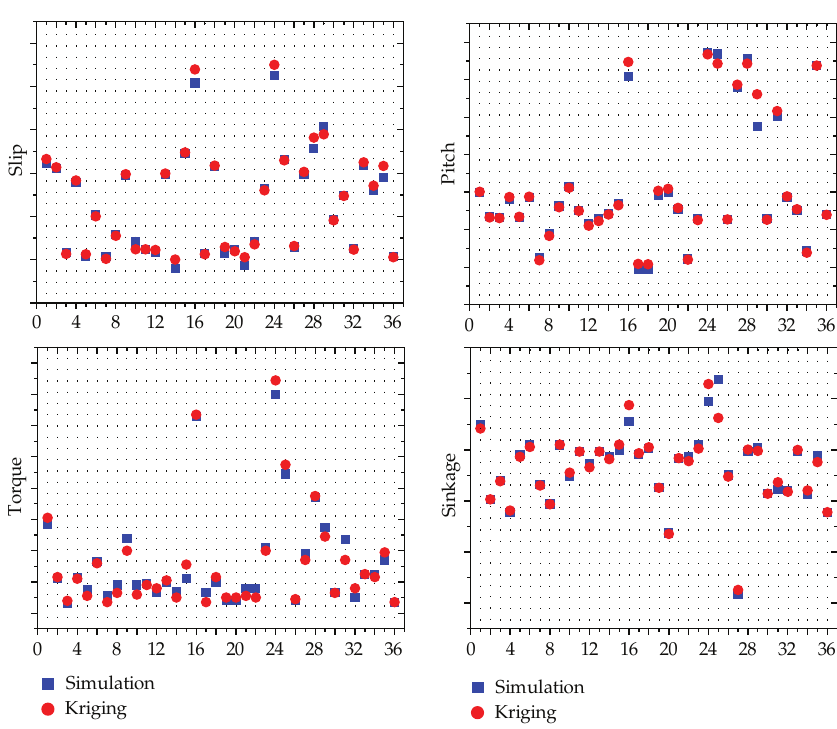
Figure 6: Comparison between crawler kriging model and simulation model for vertical sinkage, pitch angle, slip rate, and